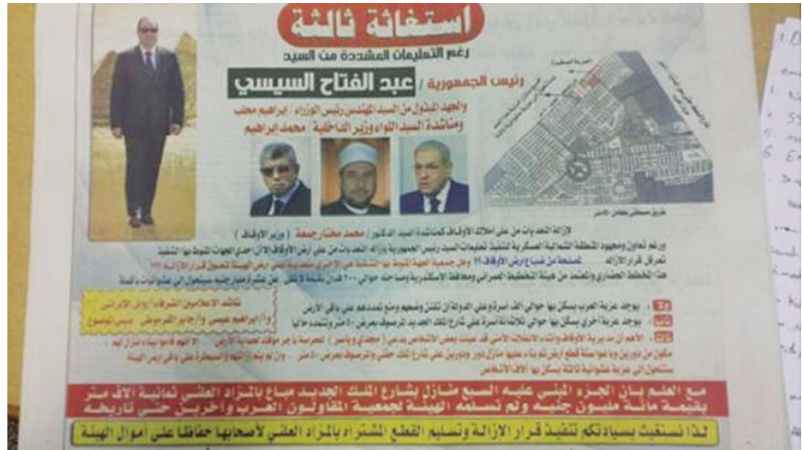
Figure 3. Front-page ad published by the Awqaf calls for the intervention of the president in evicting the residents of some land plots in Muthalath al-Monntazah. At the top right is an image of the proposed urban subdivision